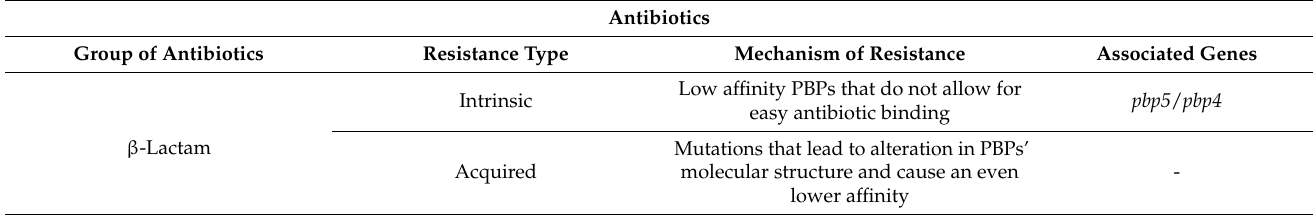
Table 2. Summary table of the main mechanisms of resistance and decreased susceptibility to antibiotics and biocides, presented by the Enterococcus